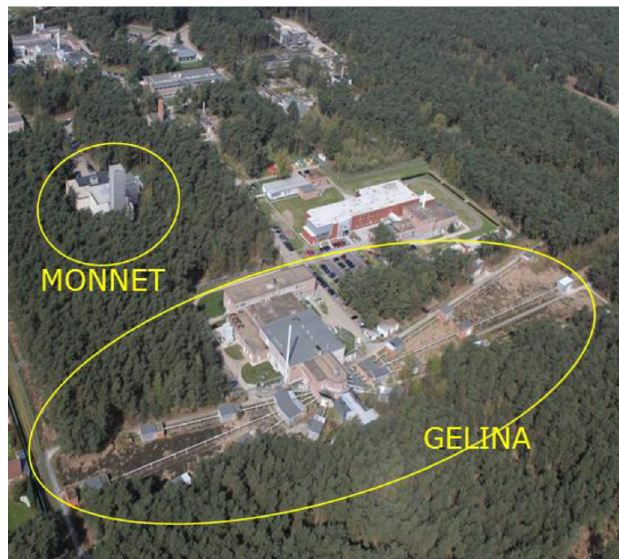
Fig. 3. Accelerators for nuclear data measurements in JRC-